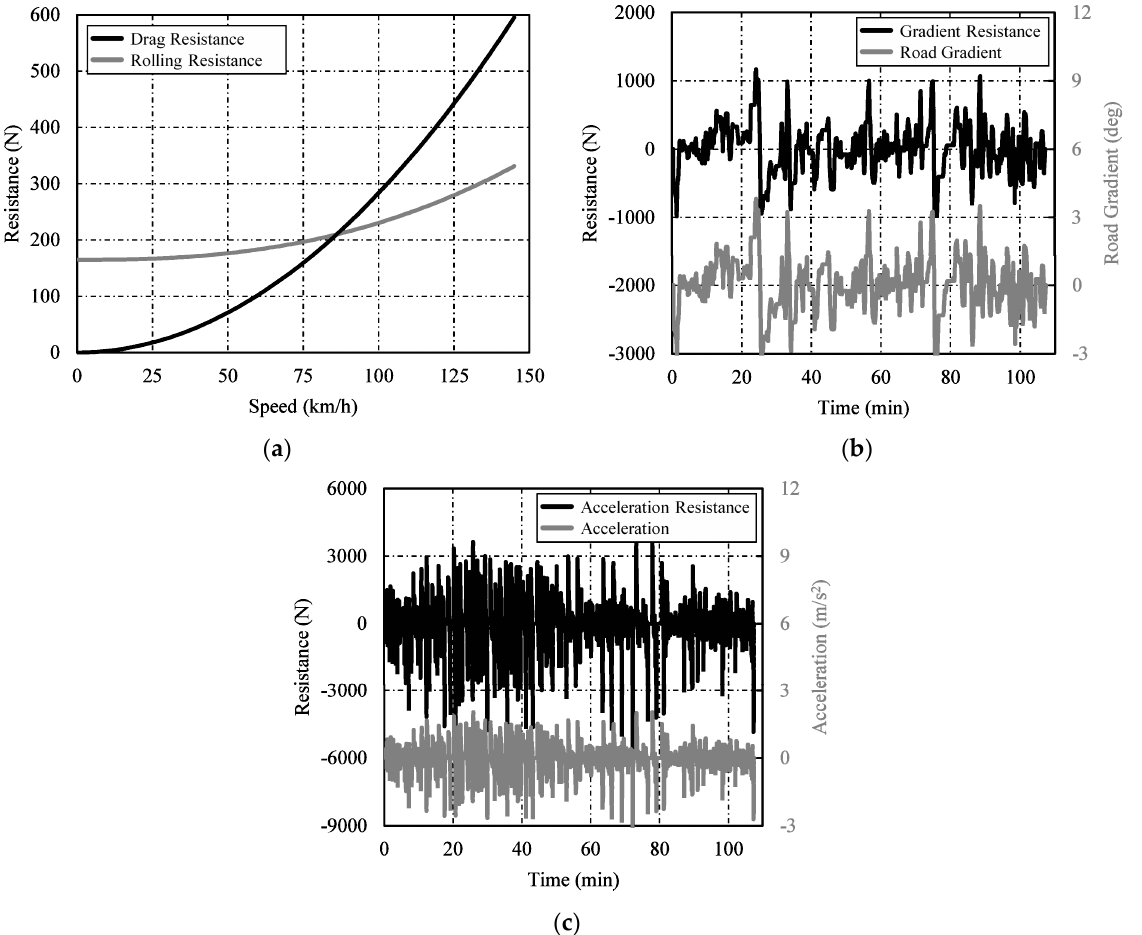
Figure 5. Calculated driving resistance forces. ( a ) Drag and rolling resistance. ( b ) Road gradient resistance. ( c ) Acceleration resistance.